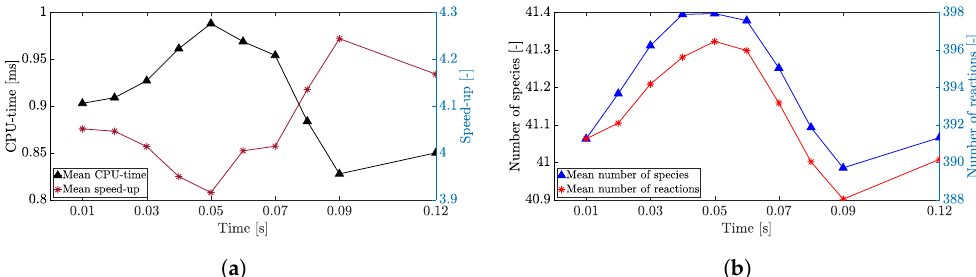
Figure 6. Statistics for several timesteps of the unsteady adaptive simulation obtained with a sinusoidal perturbation in the velocity profile ( f = 10 Hz, A = 0.25) with reduced mechanisms ( (cid:101) DRGEP = 0.005) obtained from the SKM partitioning, auto scaling criterion: ( a ). Mean CPU-time for the chemistry step and corresponding speed-up with respect to the detailed simulation over time; ( b ). Mean number of species and reactions over time.